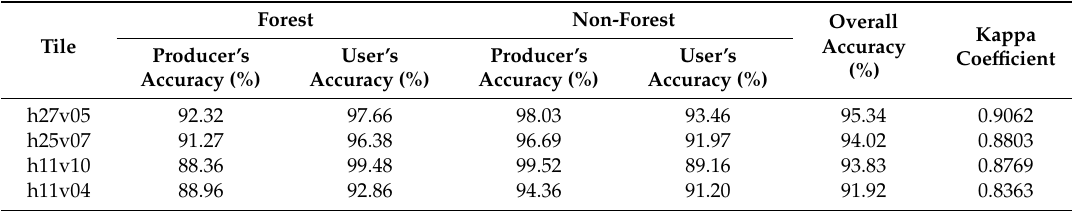
Table 2. Accuracy assessment of the extracted forest cover maps using reference ROIs from high-